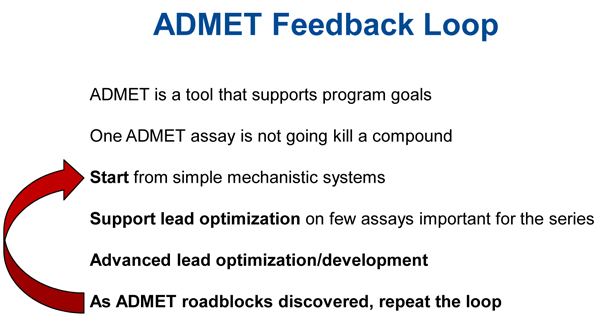
ADMET feedback loop.